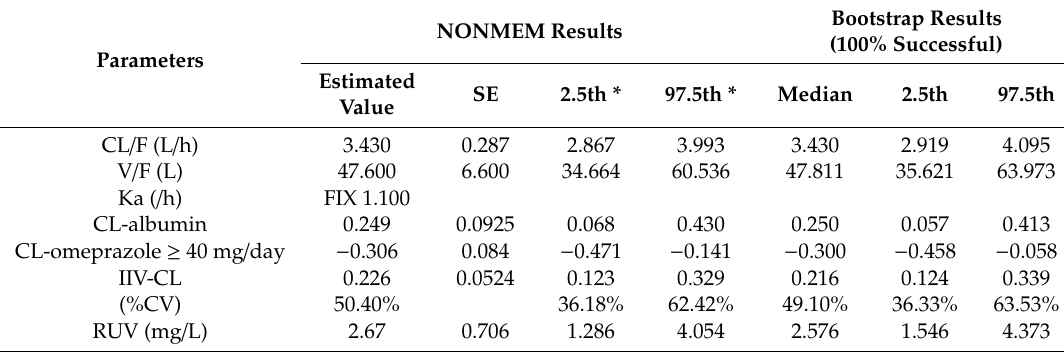
Table 2. Population pharmacokinetic parameters of